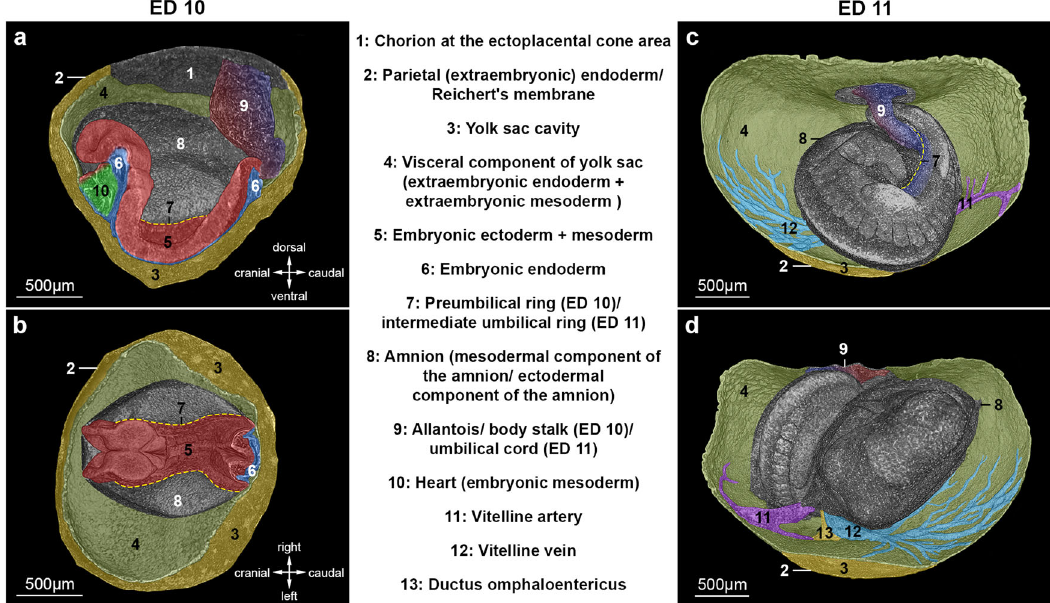
Fig. 1 Normal development from the pre- to intermediate umbilical ring and the surrounding embryonic and extraembryonic tissues. Morphological comparison of rat embryos at ED 10 (before body turning and body folding) and ED 11 (after body turning and body folding). a ED 10, right lateral view after virtual sagittal sectioning of the embryo. b Lateral view after sagittal sectioning with the head on the left. The preumbilical ring represents the border between the embryonic and extraembryonic ectoderm and is located dorsally. The allantois/body stalk is located at the most caudal part of the embryo and is connected to the chorion (developing placenta). Vitelline vessels have not yet been formed. c ED 11, view on allantois/body stalk. The embryo is turned and folded, while the orientation of the allantois/body stalk is unchanged. Vitelline vessels appear on the opposing side of the allantois/ body stalk. The midgut is still connected to the yolk sac through the ductus omphaloentericus. The preumbilical ring moves ventrally with the umbilical veins to form new borders. d ED 11, view on the vitelline vessels and the ductus